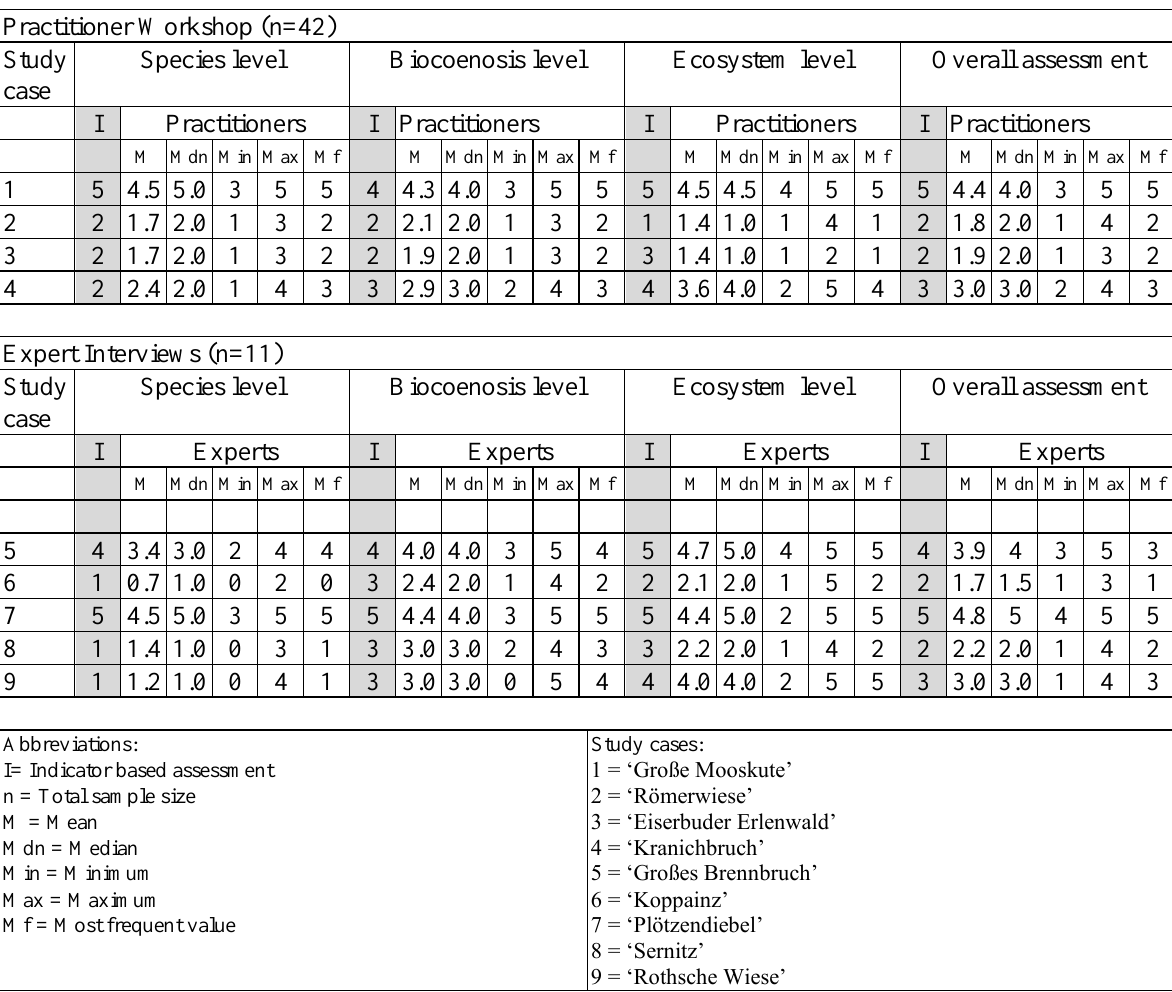
Table 12. Comparison of assessment (species, biocenosis and ecosystem level as well as overall biodiversity) via indicator system and experts/practitioners Practitioner Workshop